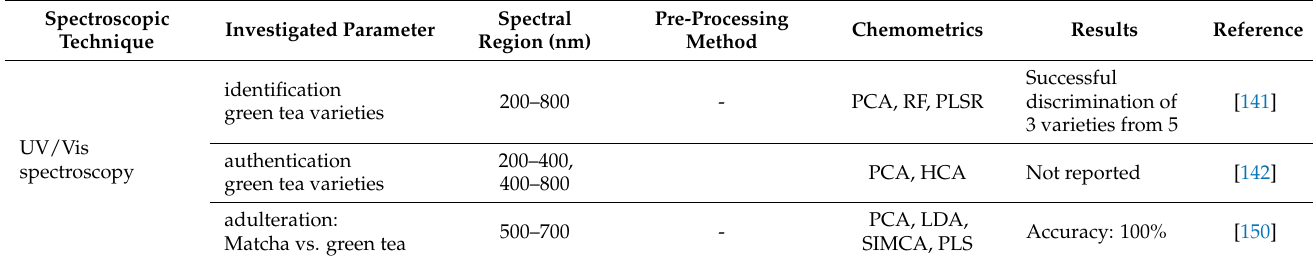
Table 8. Overview of molecular spectroscopic techniques for authentication and adulteration deter- mination in